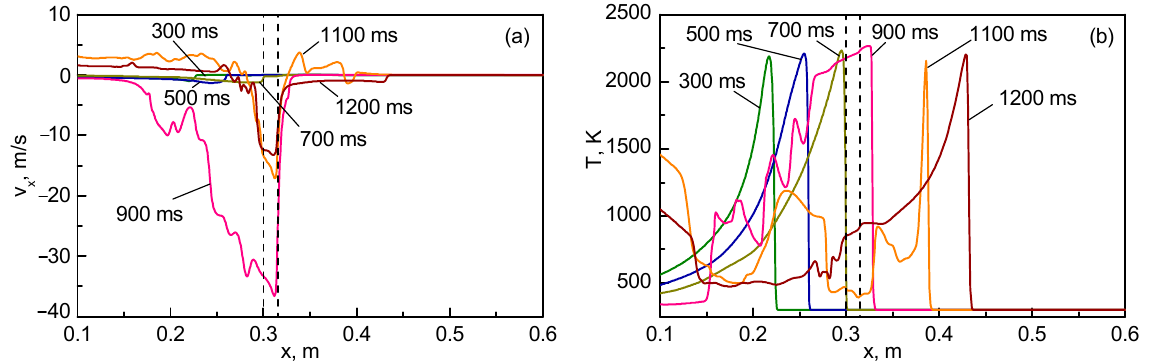
Figure 11. Longitudinal velocity ( a ) and temperature ( b ) distributions along the symmetry line at the indicated times (boundaries of the obstacle are shown by vertical dashed lines).